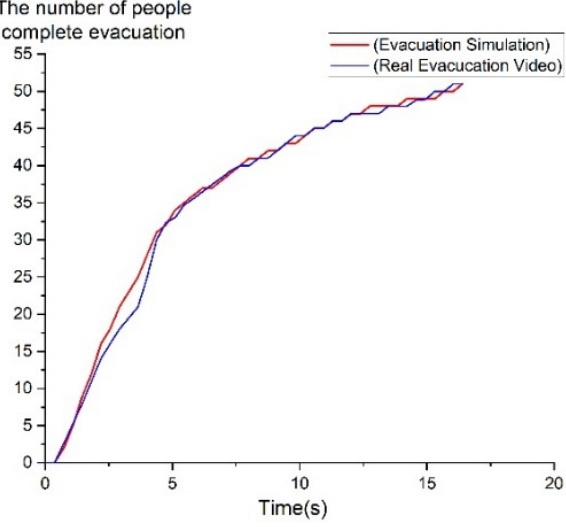
Figure 6. The relationship between time and the number of people completing evacuation.